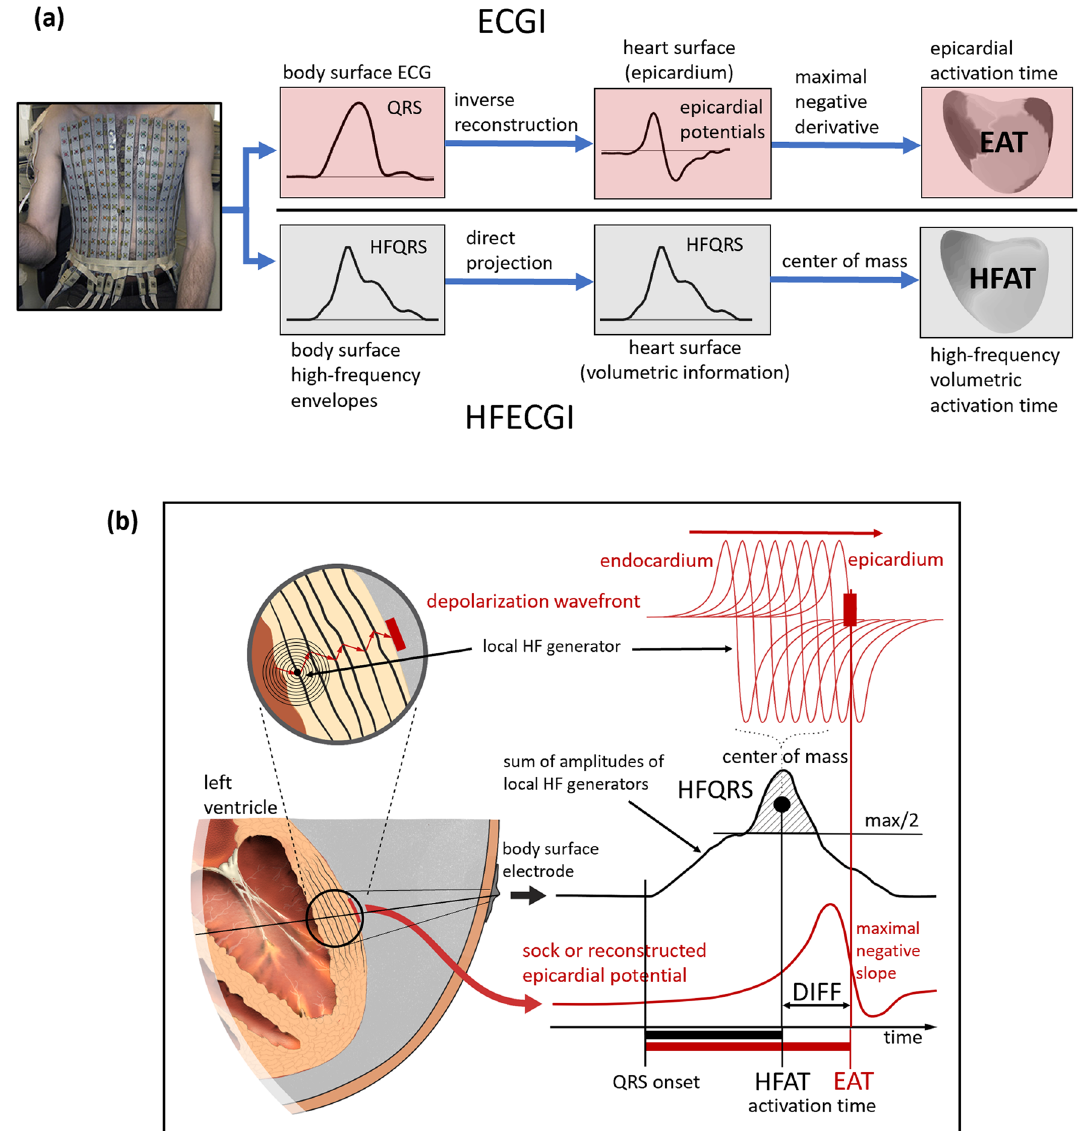
Figure 6. High-frequency electrocardiographic imaging. ( a ) Block diagram that compares the electrocardiographic imaging (ECGI) technique and high-frequency (HF) electrocardiographic imaging (HFECGI) technique. ( b ) Estimation and interpretation of epicardial activation time (EAT), HF activation time (HFAT), and their difference (DIFF). EAT is computed as the delay between the QRS onset and the maximal negative slope of epicardial potential. It corresponds to the time when the depolarization wave reaches the epicardium. HFAT is defined as the delay between the QRS onset and the center of mass (hatched area) computed from HFQRS projected on the epicardium. In this way, HFAT reflects the time when the largest amount of myocardial cells is depolarized simultaneously—activation at approximately halfway on the depolarization path across the wall. DIFF then indicates the delay between the midwall and epicardial